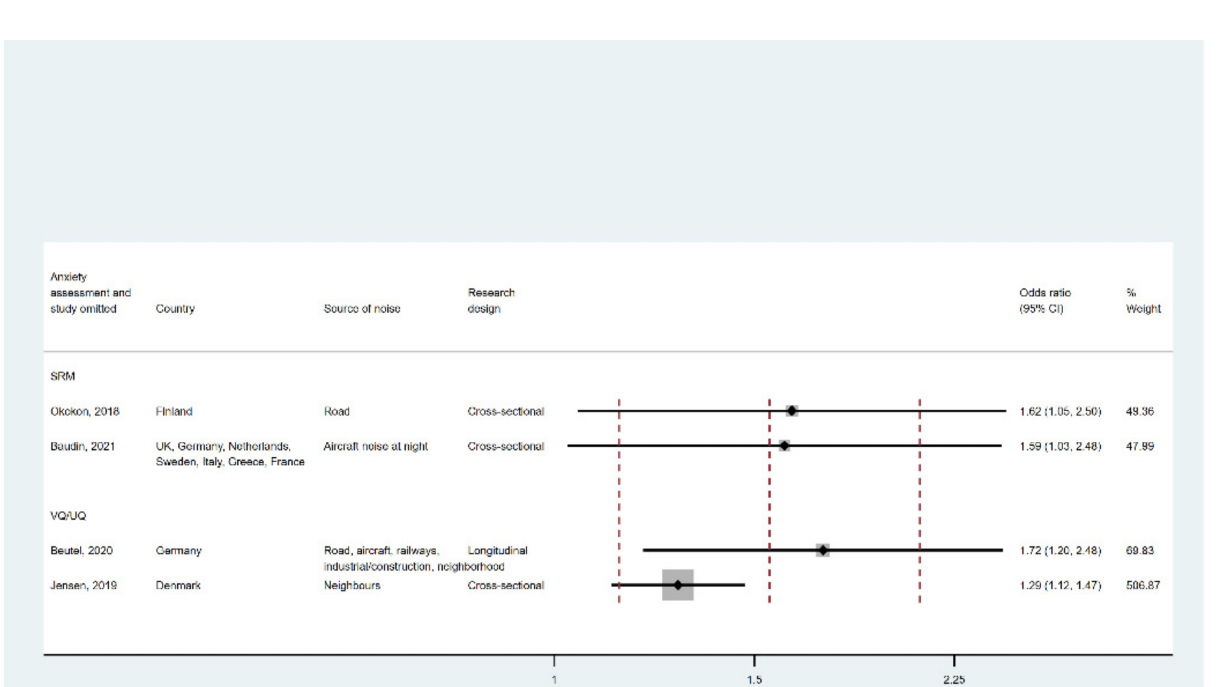
Figure A3. Leave-one-out analysis for identifying outliers in depression studies. Note: weights are from random-effects model.